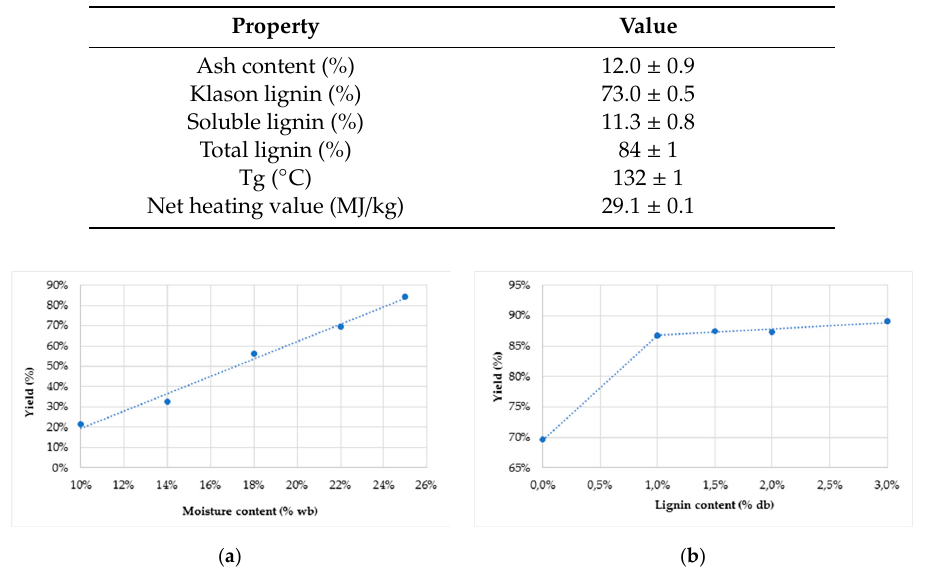
Figure 1. ( a ) Yield of pellet production versus moisture content of raw material, ( b ) yield production versus lignin content. Table 1. Physical properties of lignin used in this work. Table 2. Moisture content of pellets versus moisture content of raw material.